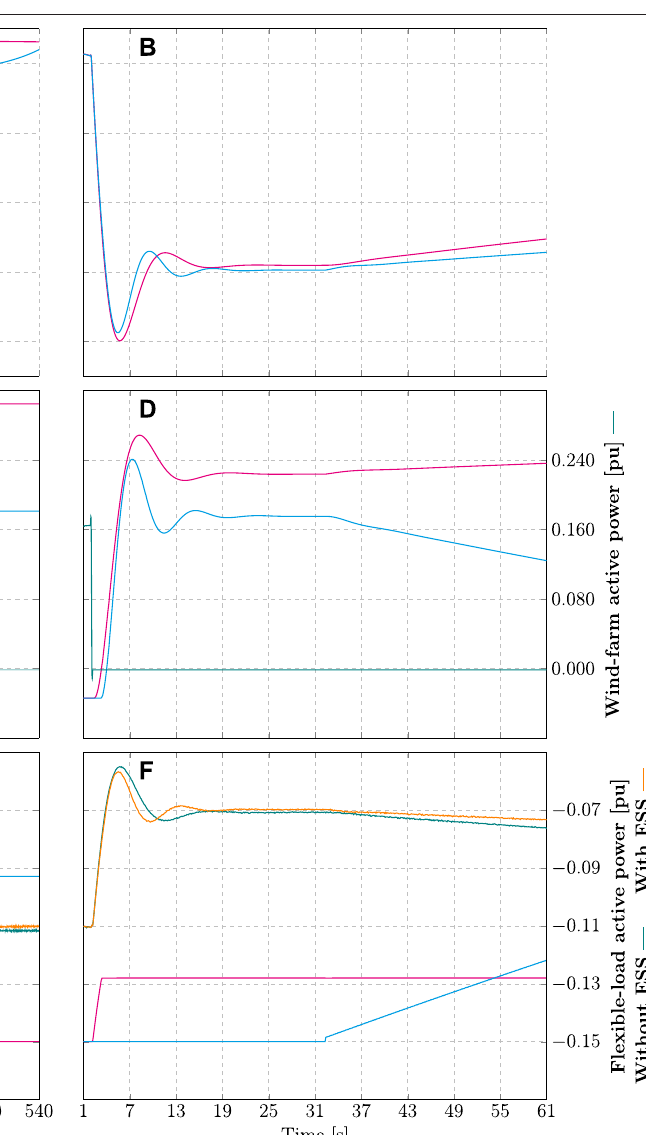
Frontiers in Energy Research |